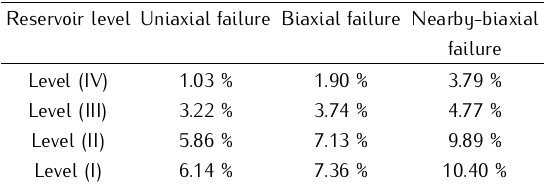
Table 7. Total percentage of the candidate nodes for